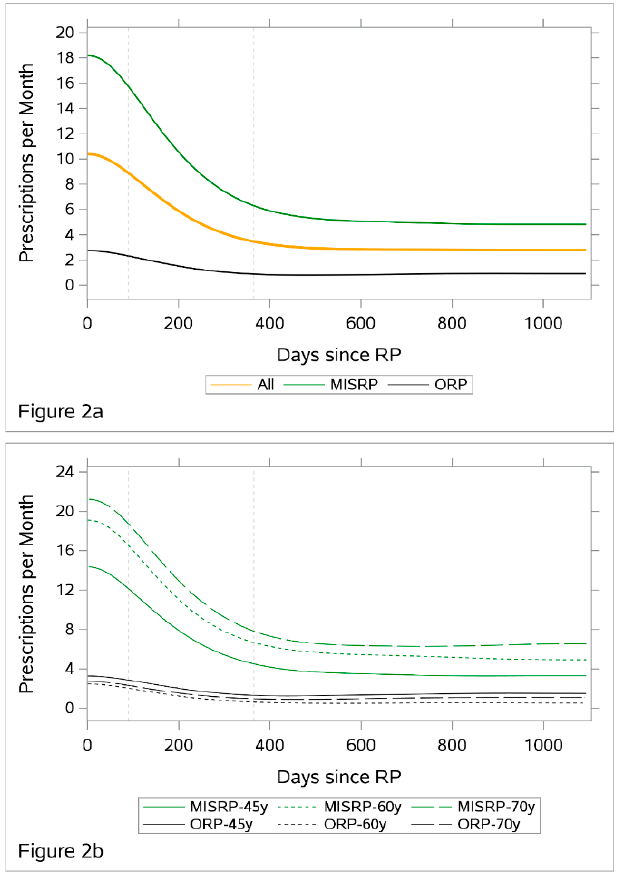
Figure 2. ( a ) Post ‐ operative monthly rate of prescribed incontinence pad among prostate cancer patients overall and by RP procedures; ( b ) post ‐ operative monthly rate of prescribed incontinence pad among prostate cancer patients overall and by RP procedures.